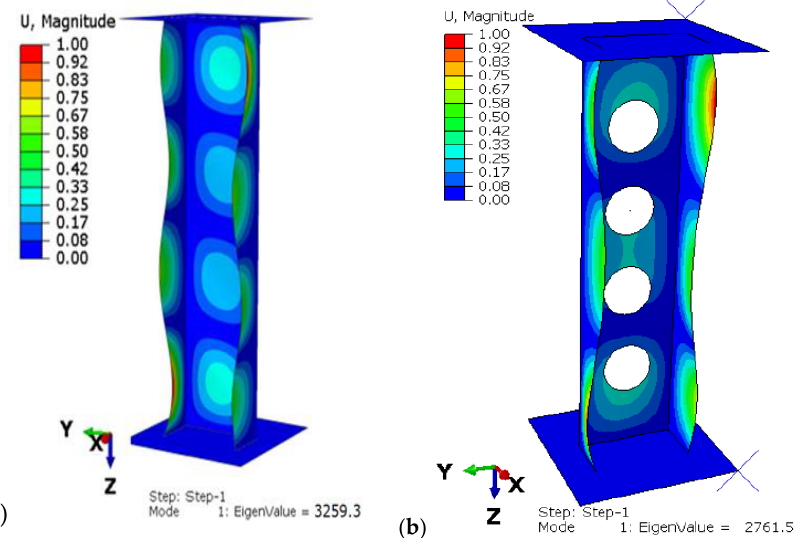
Figure 9. Buckling simulation results for the P2 lay-up: ( a ) unperforated profile, ( b ) profile with circular holes.